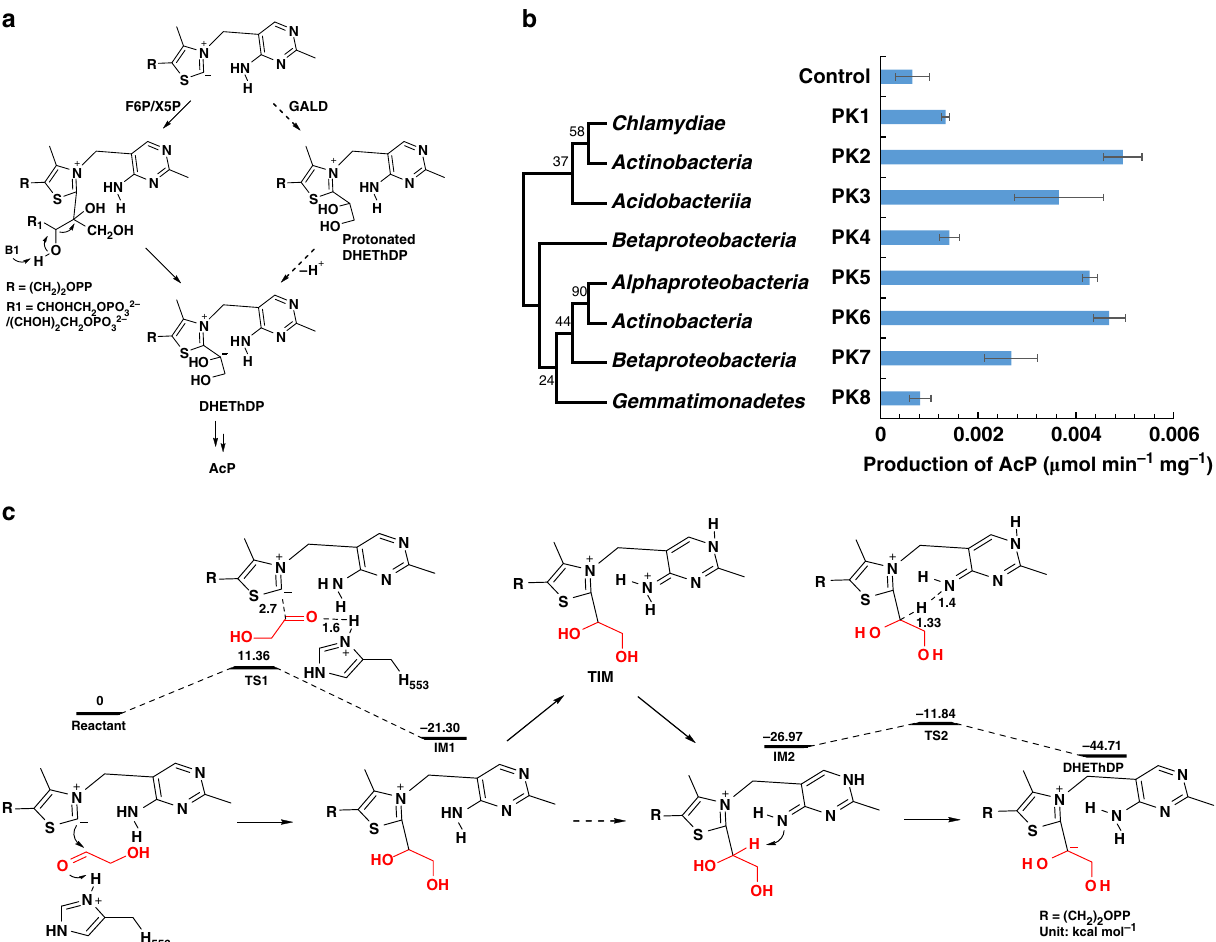
Fig. 4 Computational analysis and functional identi fi cation of the acetyl-phosphate synthase. a The formation of DHEThDP from F6P/X5P and glycolaldehyde. The solid arrows represent the formation mechanism of DHEThDP in ref. 39 ; the dashed arrows indicate the predicted process using glycolaldehyde as substrate. b The identi fi cation of ACPS. The maximum-likelihood phylogenetic tree of the selected eight PKs was constructed by MEGA 47 . The details of the selected PKs are present in the supplementary note and supplementary Fig. 10. The activity of each protein was detected by adding 0.5 mg mL − 1 enzyme and 10 mM glycolaldehyde. AcP acetyl phosphate, PK phosphoketolase, Production of AcP ( µ mol min − 1 mg − 1 ): the amount of AcP produced per mg enzyme per minute; Control: no enzyme was added in the reaction system; Error bars represent s.d. (standard deviation), n = 3. c The energy pro fi le for DHEThDP formation process. IM1 and IM2 represent intermediate 1 and 2 during the formation process; TIM represents the tautomerized intermediate between IM1 and IM2; TS1 and TS2 represent the transition states. Source data are provided as a Source Data fi